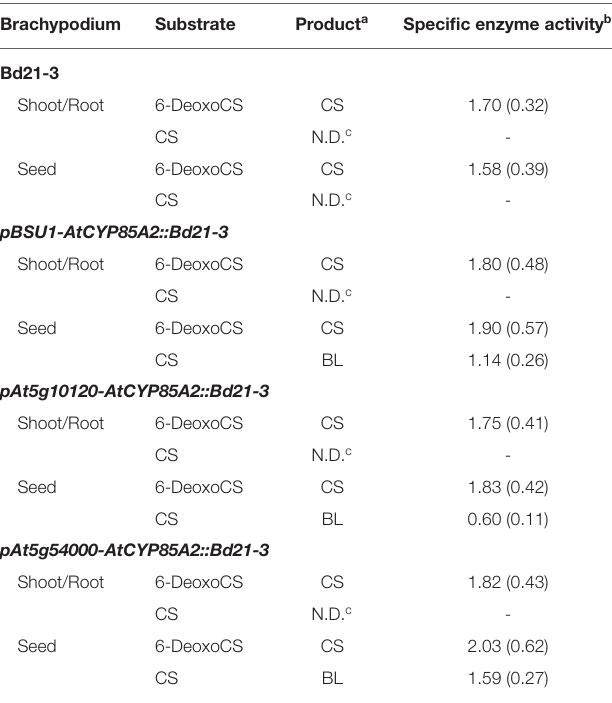
TABLE 2 | Conversion of 6-deoxoCS and CS by the crude enzyme solution prepared from Brachypodium.